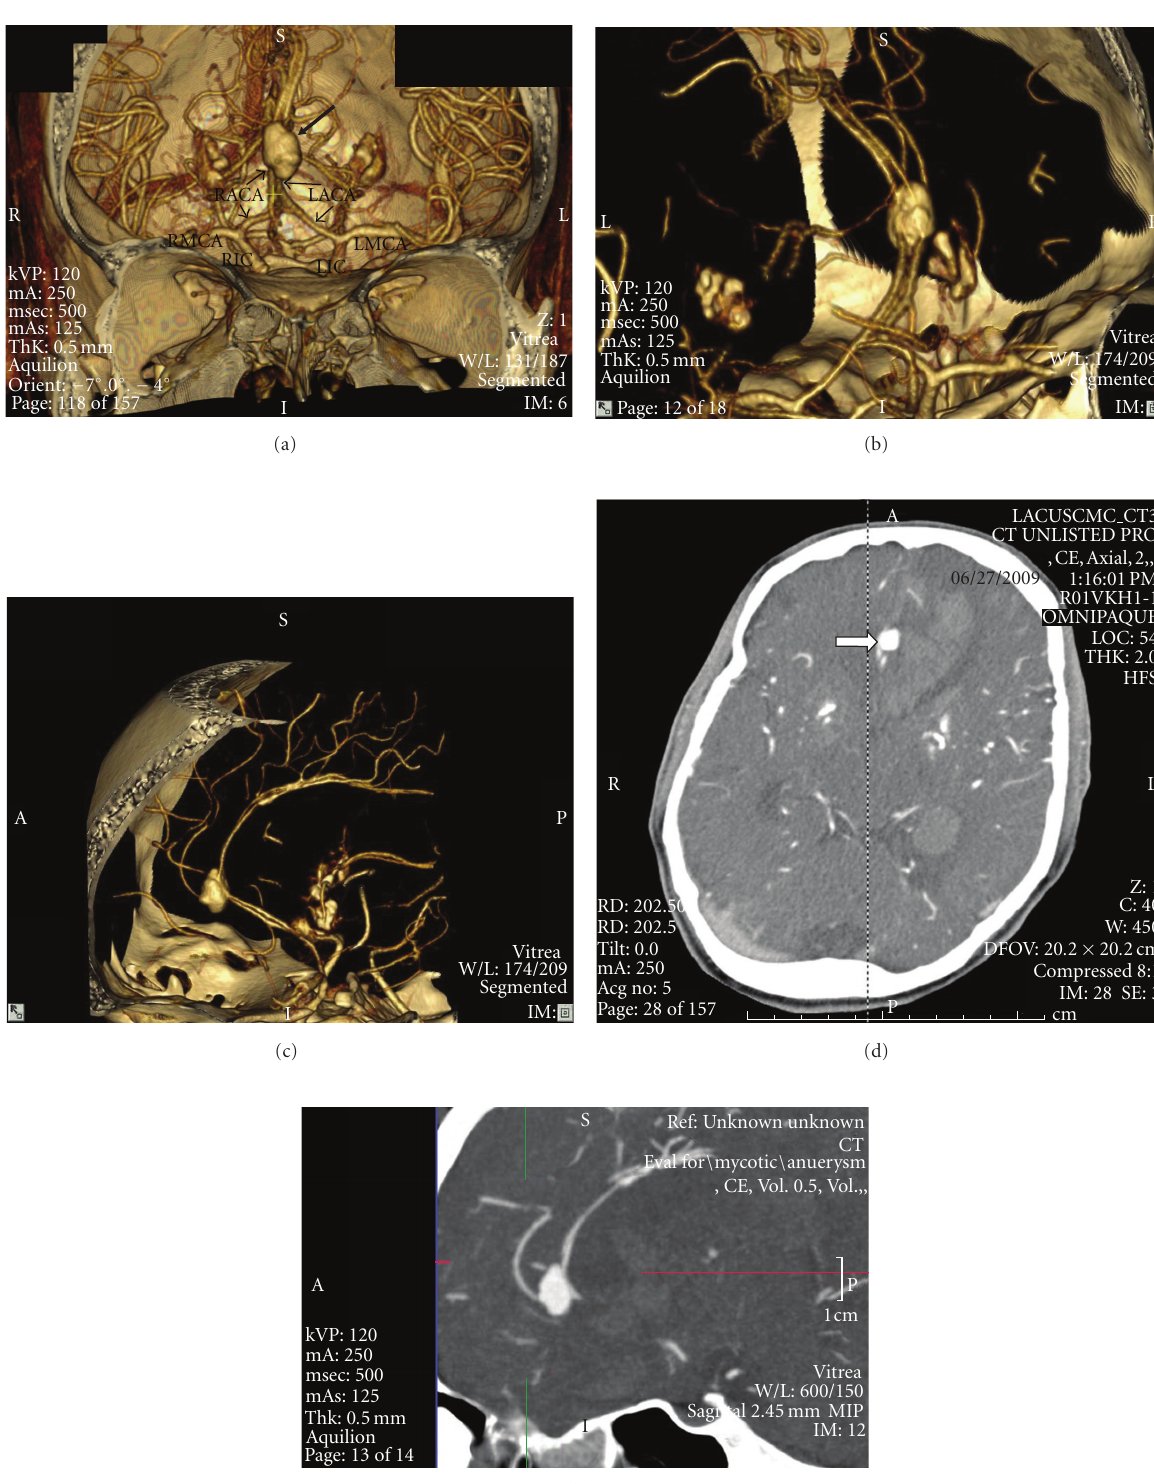
Figure 4: CT Cerebral angiogram showing a large fusiform aneurysm at the distal anterior cerebral artery (ACA). (a) Shaded Surface Display CT coronal view showing a large fusiform aneurysm at the distal segment of the ACA marked by the large arrow. Proximal ACA segments are marked by the smaller arrows. RIC: right internal carotid artery, LIC: left internal carotid artery, RMCA: right middle cerebral artery, LMCA-left middle cerebral artery, RACA and LACA are right and left anterior cerebral arteries, respectively. (b) Close-up coronal view of ACA mycotic aneurysm. (c) Additional sagital view of mycotic aneurysm. (d) CT Angiogram axial view, an arrow marks the location of the ruptured aneurysm adjacent to a large hemorrhagic lesion. (e) CT Angiogram sagital view demonstrating areas of intracerebral